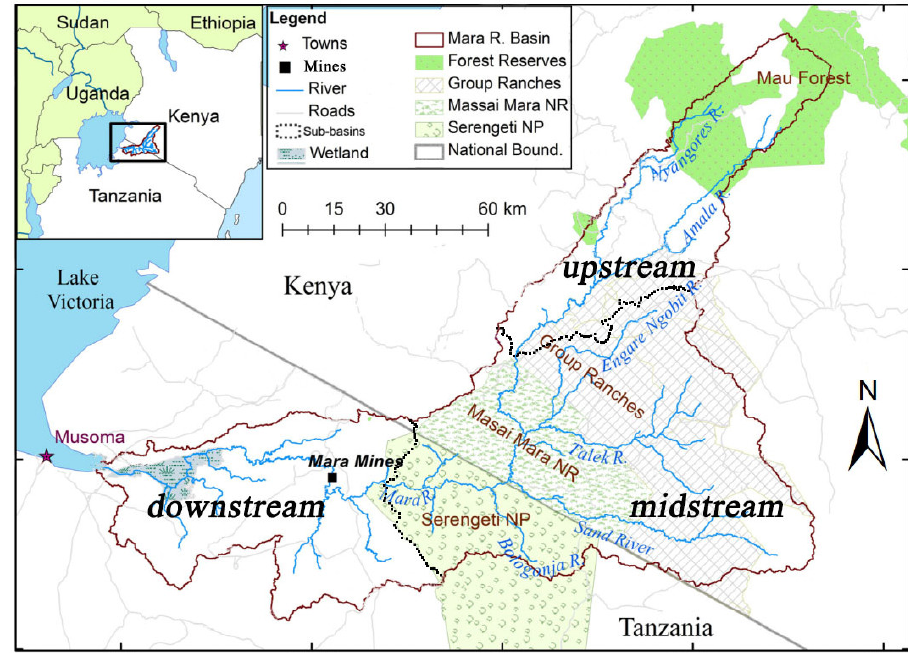
Figure 1. Location Map of the Mara River Basin.